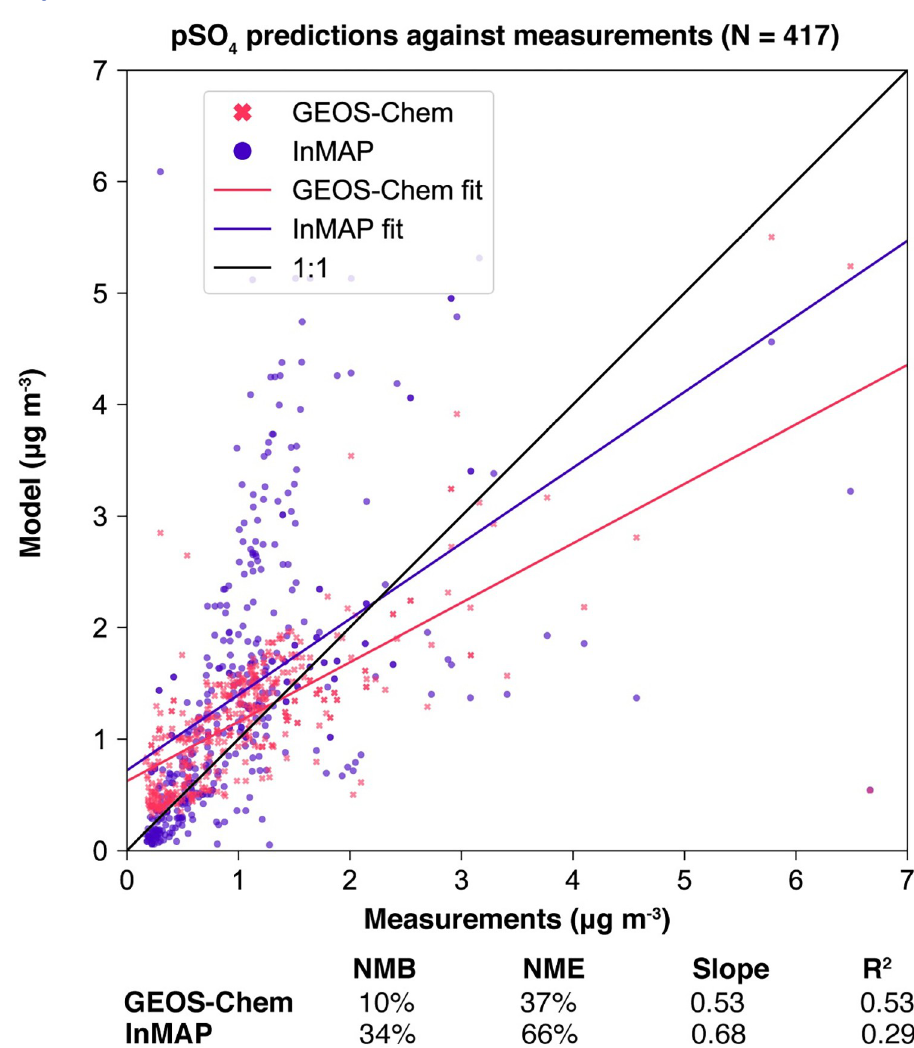
Fig 6. Global InMAP and GEOS-Chem annual-average pSO 4 concentrations against measurements. https://doi.org/10.1371/journal.pone.0268714.g006 PLOS ONE | https://doi.org/10.1371/journal.pone.0268714 May 25,